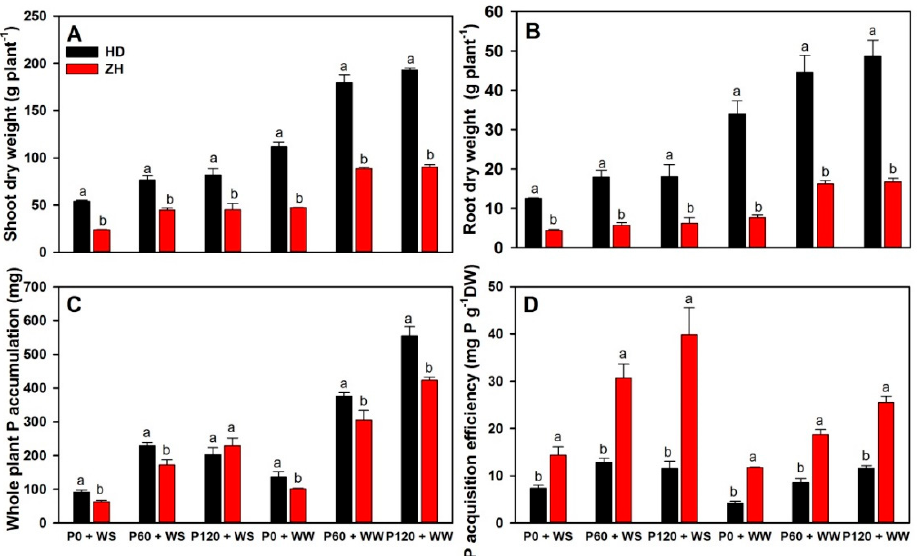
Figure 3. The ( A ) shoot dry weight, ( B ) root dry weight, ( C ) whole plant P accumulation, and ( D ) P acquisition efficiency at maturity in two cultivars (Huangsedadou (HD) and Zhonghuang 30 (ZH) under two water regimes (well-watered (WW) and cyclic water stress (WS)) and three P rates (0 (P0), 60 (P60), and 120 (P120) mg P kg –1 dry soil). Means (±SE) with different letters in the same panel are significantly different at p = 0.05.